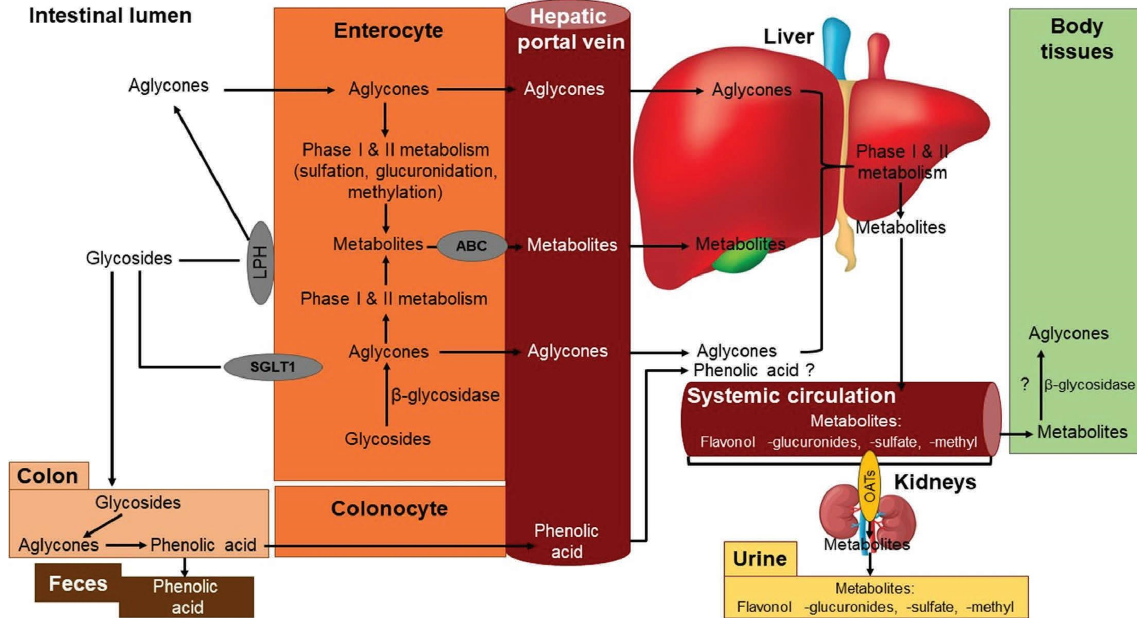
Figure 2: General overview of dietary kaempferol